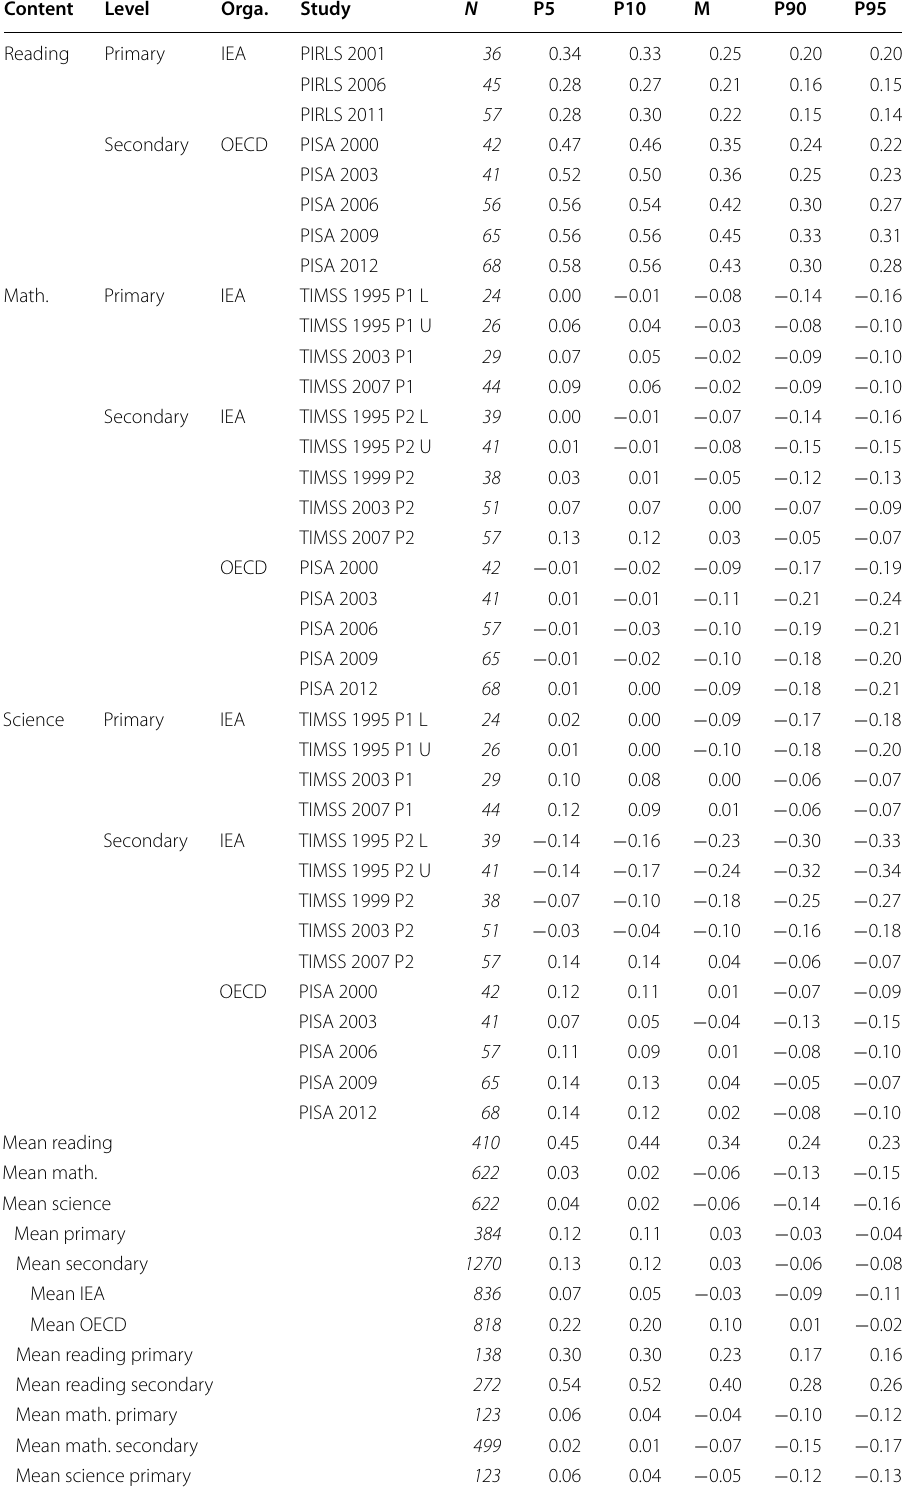
Table 1 Gender effect sizes in mean and extreme tails of the distribution in in reading, math. and science, by survey Content